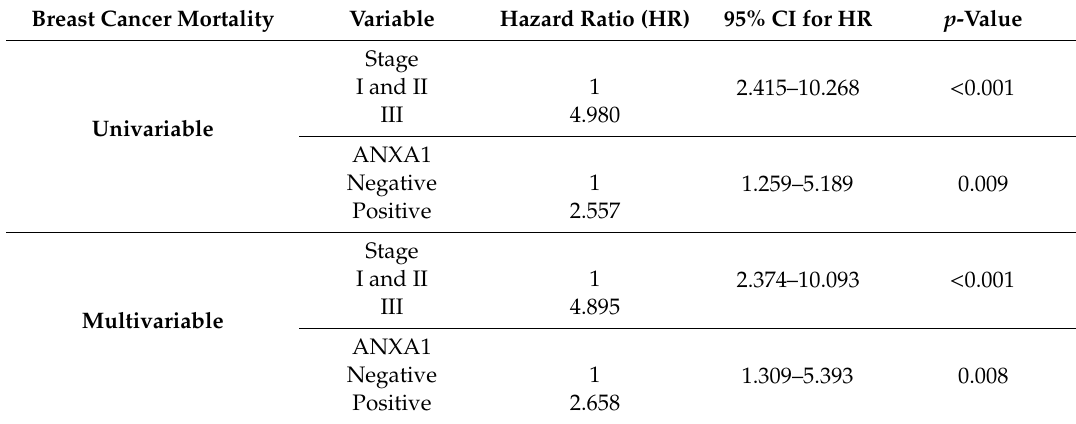
Table 3. Cox regression models assessing the potential of clinical variables and ANXA1 immunoexpression in the prediction of breast cancer mortality.